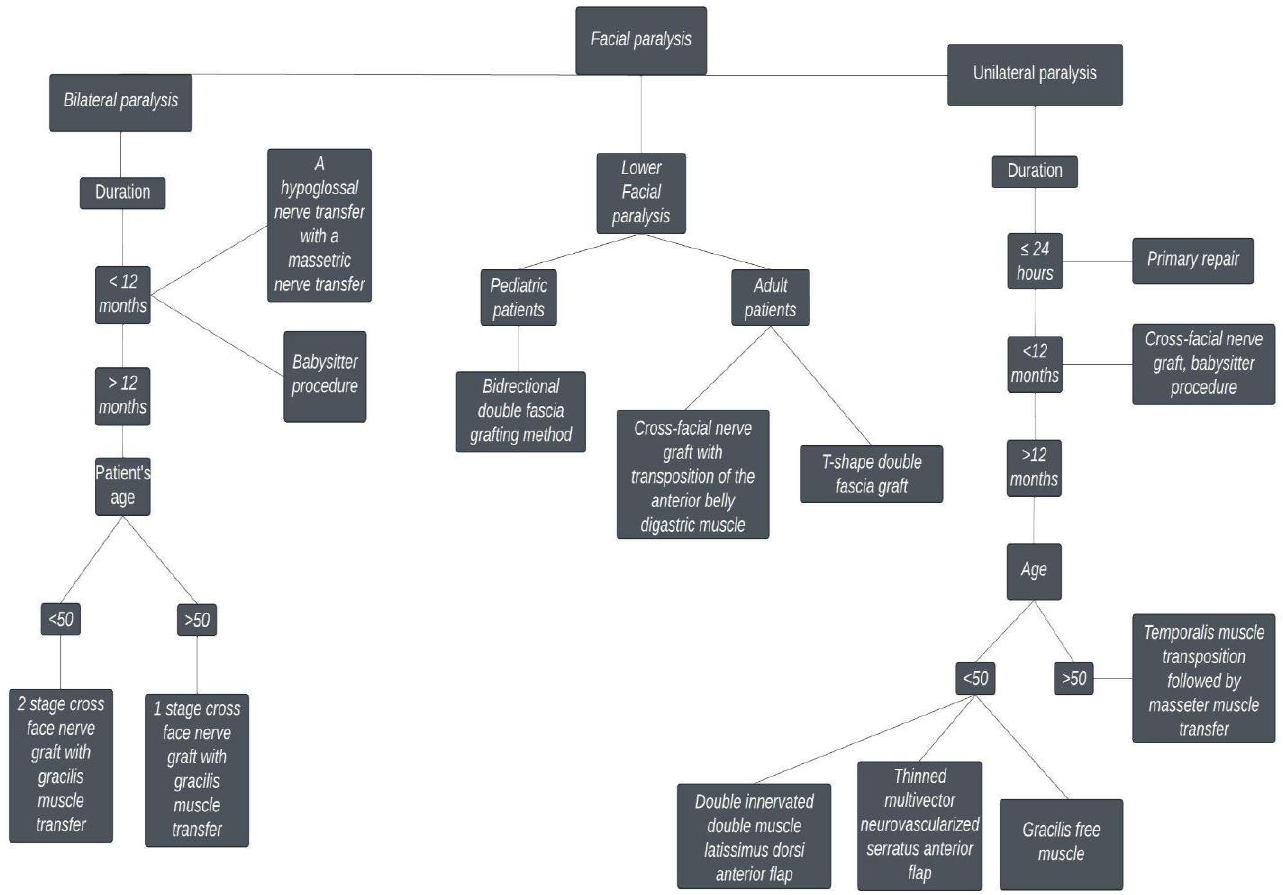
Figure 2. A recommended comprehensive approach to facial